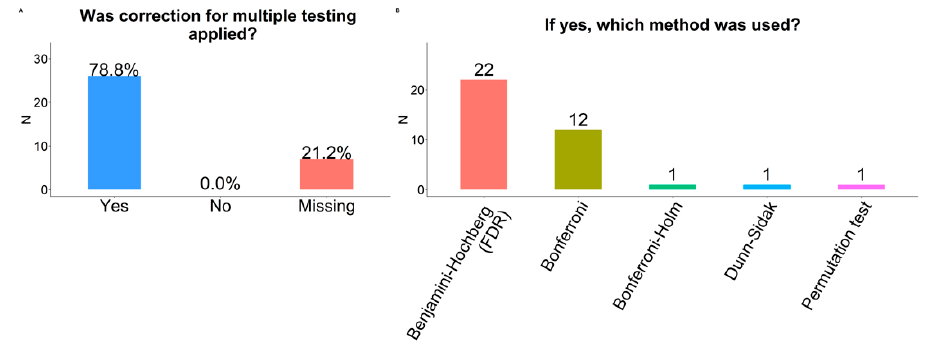
Figure 5. Strategies for correcting for multiple hypothesis testing among participating COMETS cohorts. ( a ) Use of multiple testing correction (yes/no); ( b ) Methods for correcting for multiple hypothesis tests.